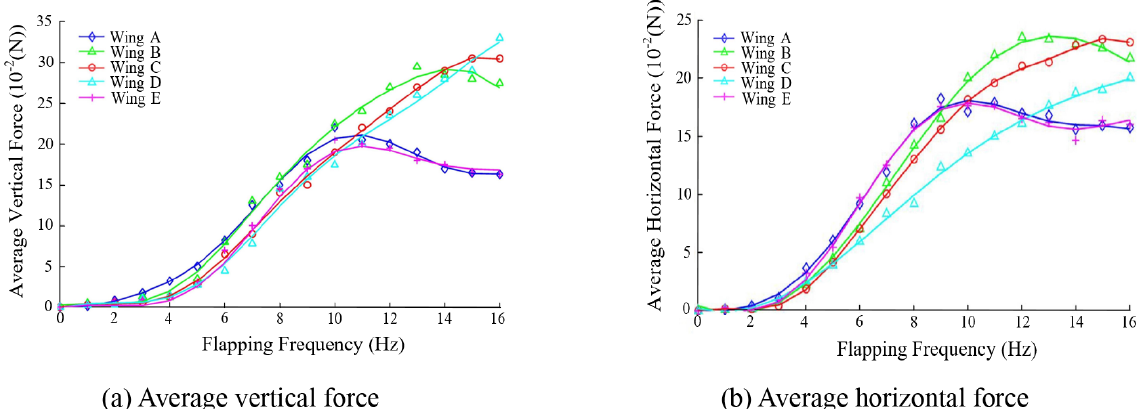
Figure 10. Aerodynamic forces of different wings vs. flapping frequency.